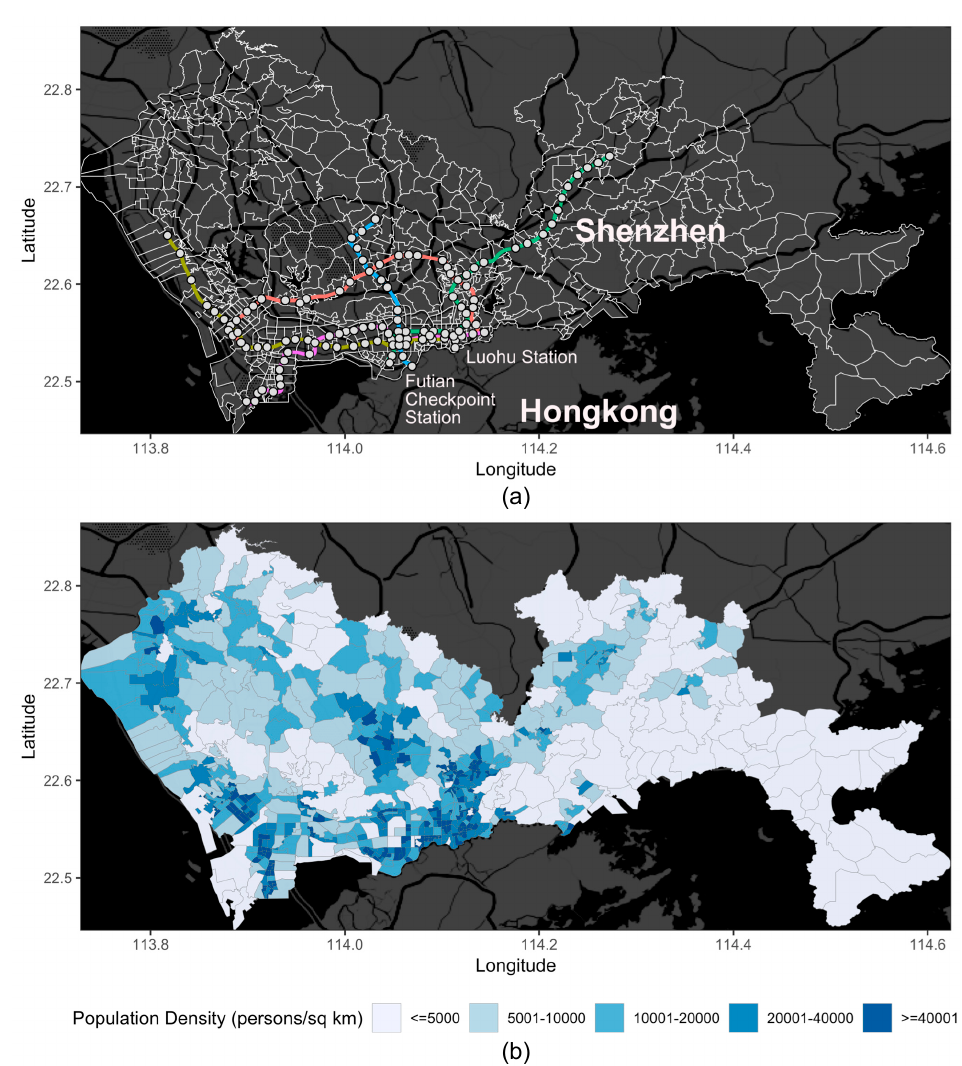
Figure 1. ( a ) The Shenzhen metro system with community level administrative zones and ( b ) population density.